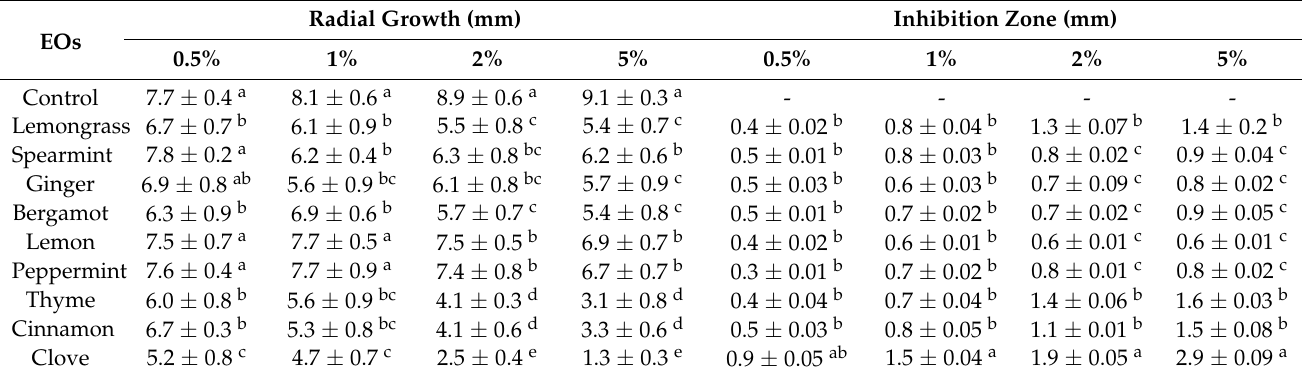
Values are mean ± standard deviation (n = 6). Different superscripts within the same column followed by different letters (a–e) indicate a significant difference ( p < 0.05). Concentrations of different EOs are presented in µ g/100 µ L. The in vitro MIC and MFC values of the different levels of EOs attained in the mi- croplate wells inoculated with serially diluted Aspergillus sp. culture are presented in Table 2. Lower values of MIC were obtained in lemongrass, thyme, and clove EOs than the other EOs ( p < 0.05). The MIC values of the aforementioned EOs at the 1–5% level could inhibit the growth of mycelium formation in a dose-dependent pattern. However, MIC values were the lowest in 5% CEO compared to the other EOs ( p < 0.05). Similarly, MFC values of EOs were half of the concentrations of MIC. Moreover, the decreases in MFC values for 5% CEO depict that the lowest concentration of CEO was employed for effective inhibition of Aspergillus sp. It was reported in a study that different EOs from oregano, clove, thyme, lavender, clary sage, and arborvitae at various concentrations of 75, 50, 25, 10, and 5% ( w / v ) were employed against Alternaria alternata and Aspergillus fumigatus . The mycelial growth of the tested fungal strains was retarded by oregano and clove, having MICs of 0.01% and 0.025% and MFCs of 0.025% and 0.05%, respectively [38]. A comparative study of thyme, oregano, and lemon EOs reported that Botrytis cinerea , Penicillium italicum , and Penicillium digitatum were inhibited by thyme EO more effectively [28]. Additionally, EO from cloves during the in vitro vapor phase with an MIC value of 92.56 µ L/L air was documented to inhibit the mold growth triggered by B. cinerea [10]. As a matter of fact, plant EOs containing volatile polyphenolic compounds such as terpenes, phenolics, alde- hydes, and alcohols that exhibit antimicrobial or fungicidal activity might alter or inhibit the growth mechanism of food-borne pathogenic fungal species [39]. Table 2. Antifungal properties of EOs on Aspergillus sp. treated without and with different levels of EOs.